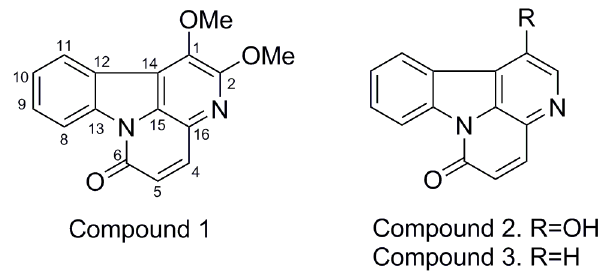
Figure 1. Canthin-6-one alkaloids isolated from Picrolemma huberi bark.